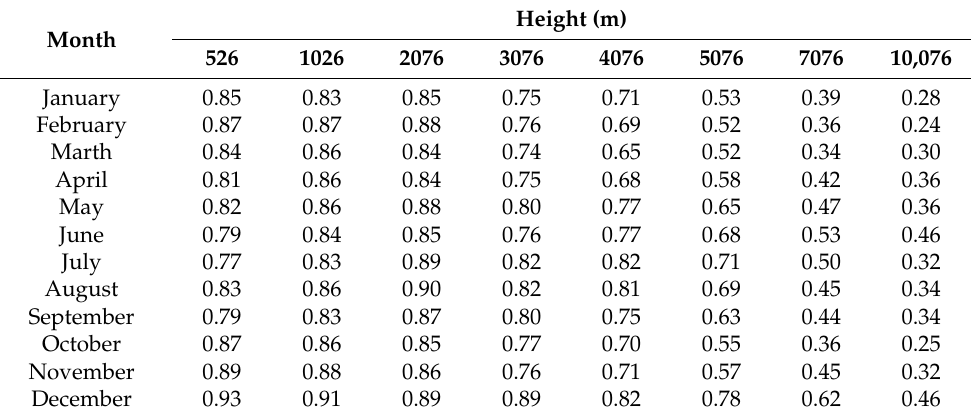
Table A1. Correlation coefficients between zenith wet delay and water vapor pressure of Qingdao station at different heights and months.